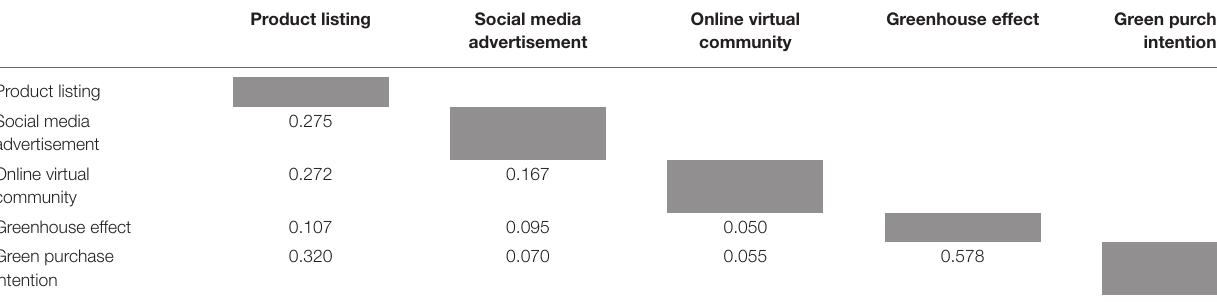
TABLE 4 | HTMT analysis of variables.